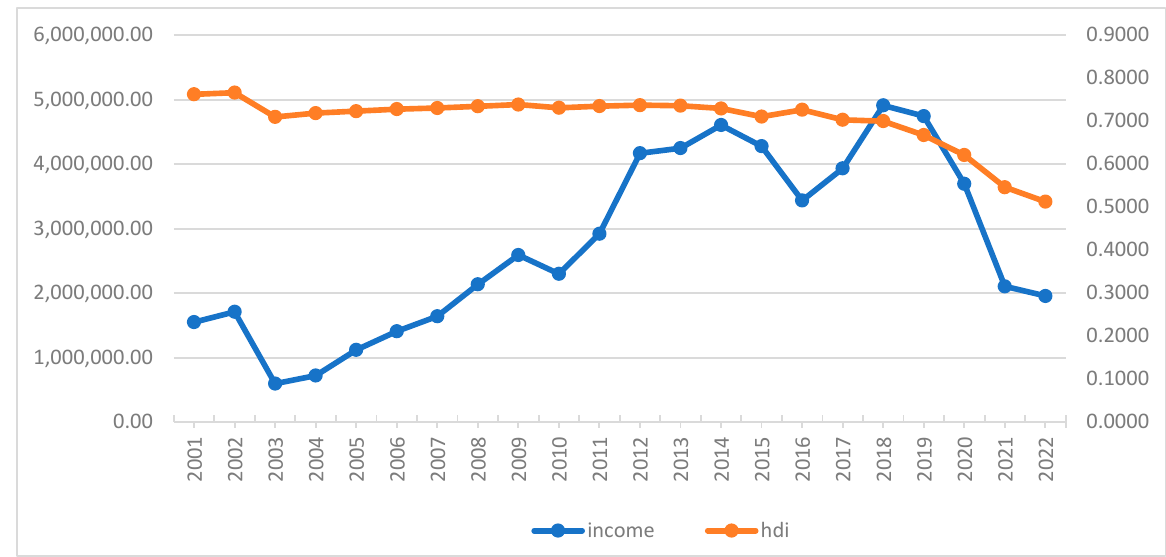
Figure 10. HDI and FRA Cuyo 2001–2021. Source: DNCFP.